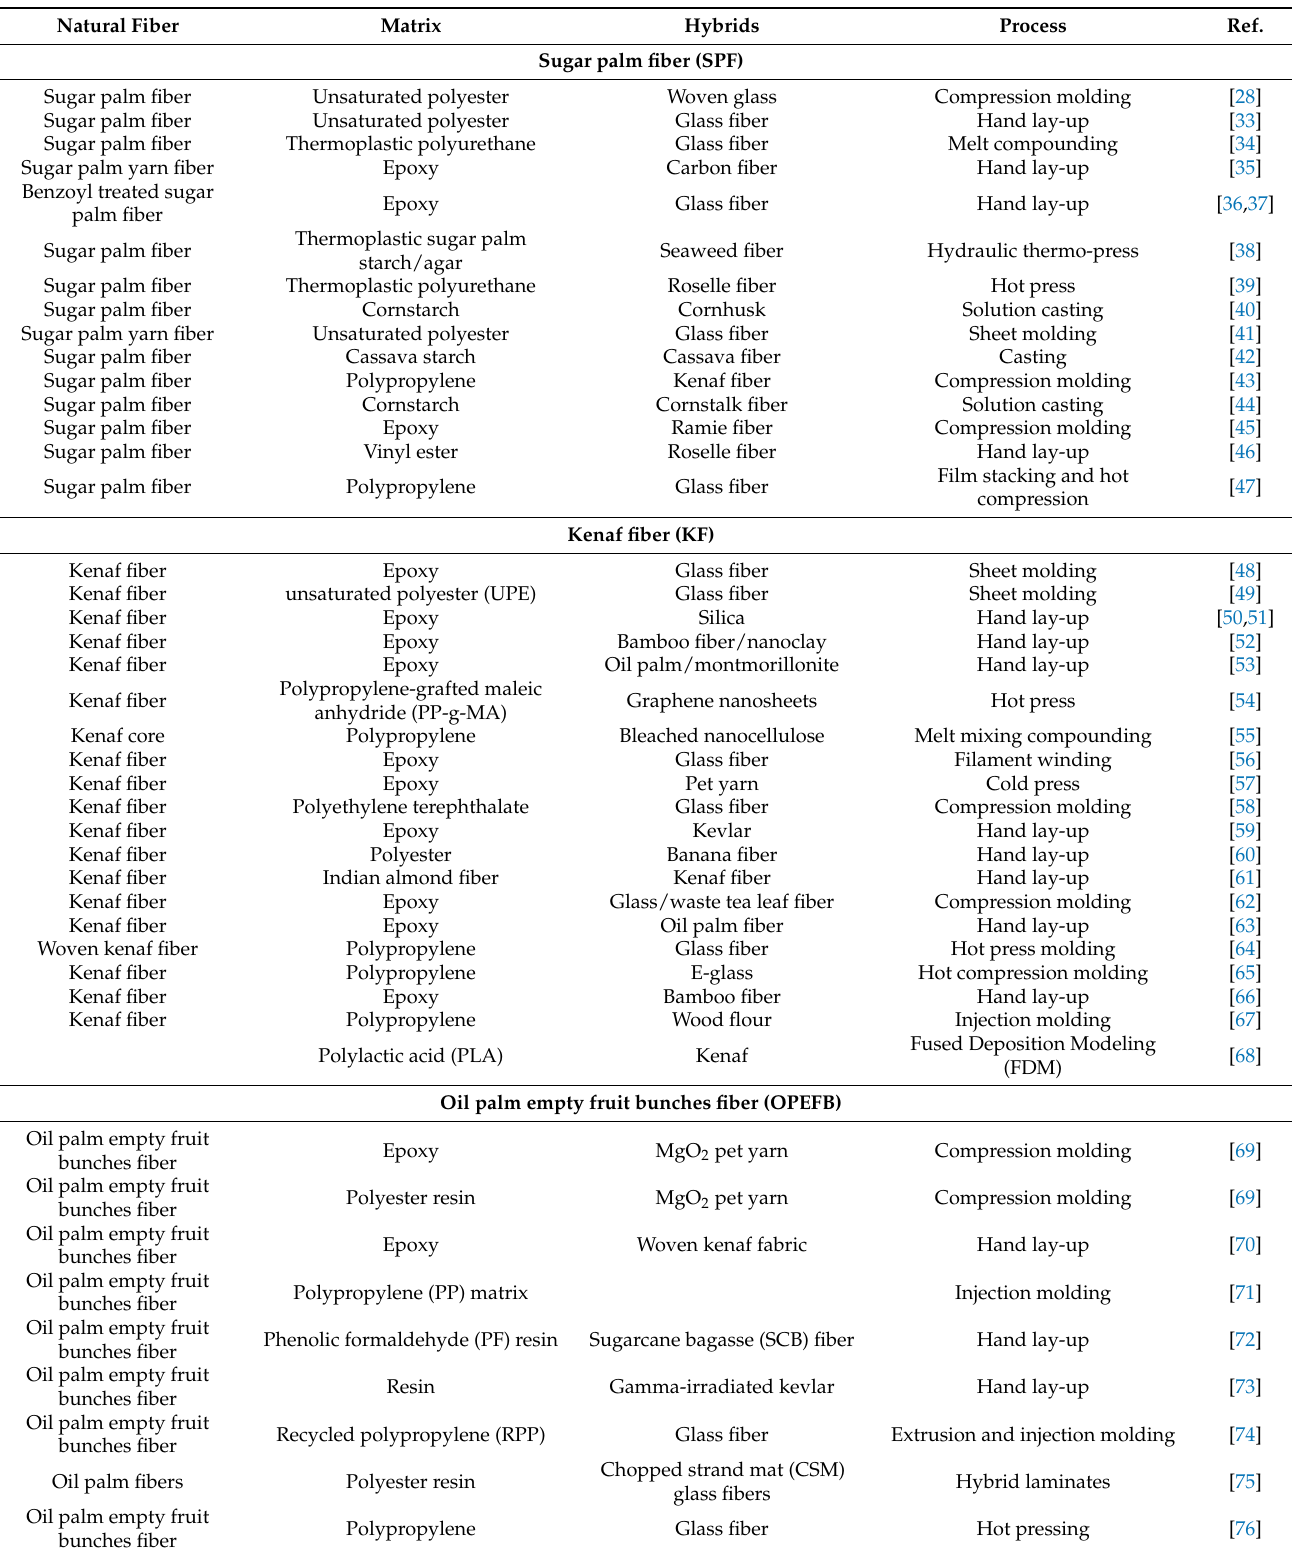
Table 2. Natural fiber reinforced hybrid